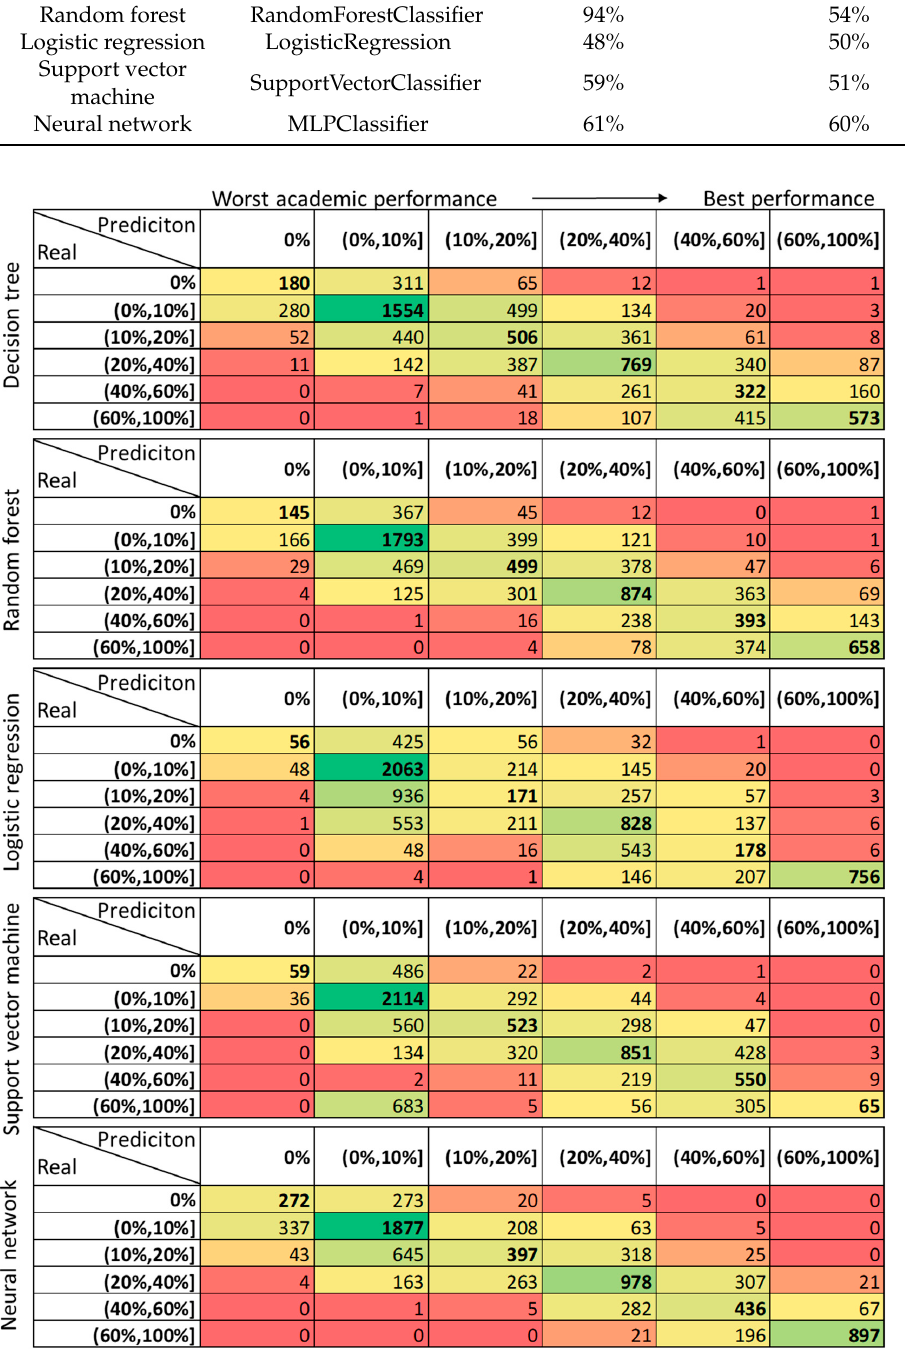
Figure 6. Percentage of advanced students by ML models (Prediction versus reality). Bold suggests the correctly predicted. The color green indicates a relatively high numerical value, with deeper shades of green indicating even higher values. Yellow signifies intermediate numerical values. Conversely, the color red indicates relatively low numerical values, with deeper shades of red indicating even lower